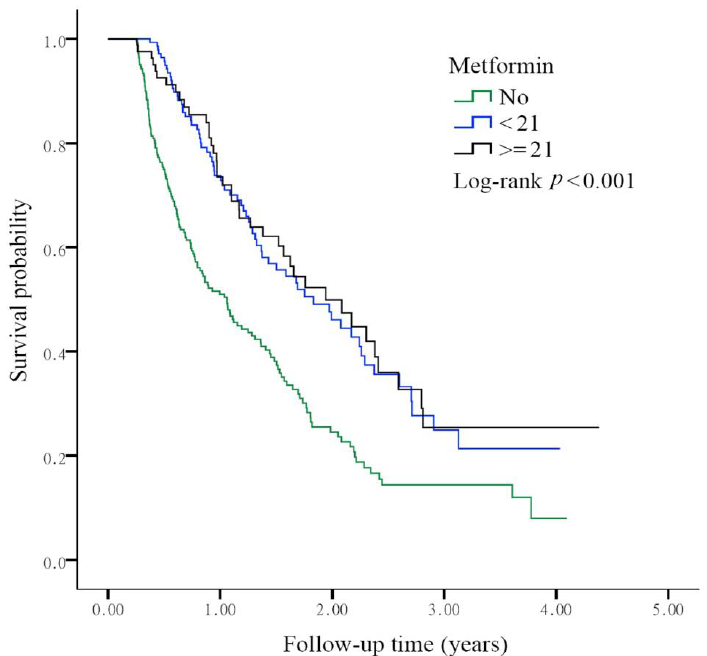
Figure 4. Overall survival status based on the cumulative defined daily dose (DDD) of metformin prescribed during the first 3 months after lung cancer diagnosis. The survival probability was analyzed by the Kaplan-Meier method in the three different groups (non-metformin user, the aHR for DDD < 21 and DDD ≥ 21). The log-rank test was p <